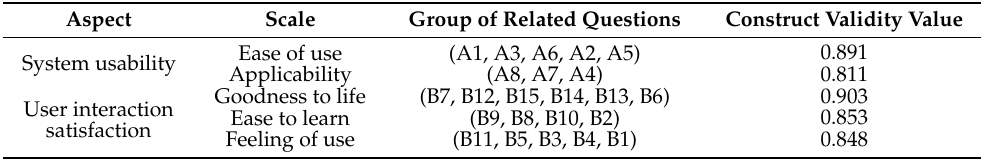
Table A10. The values of construct validity of the scales of the two aspects of system usability and user interaction satisfaction computed by the